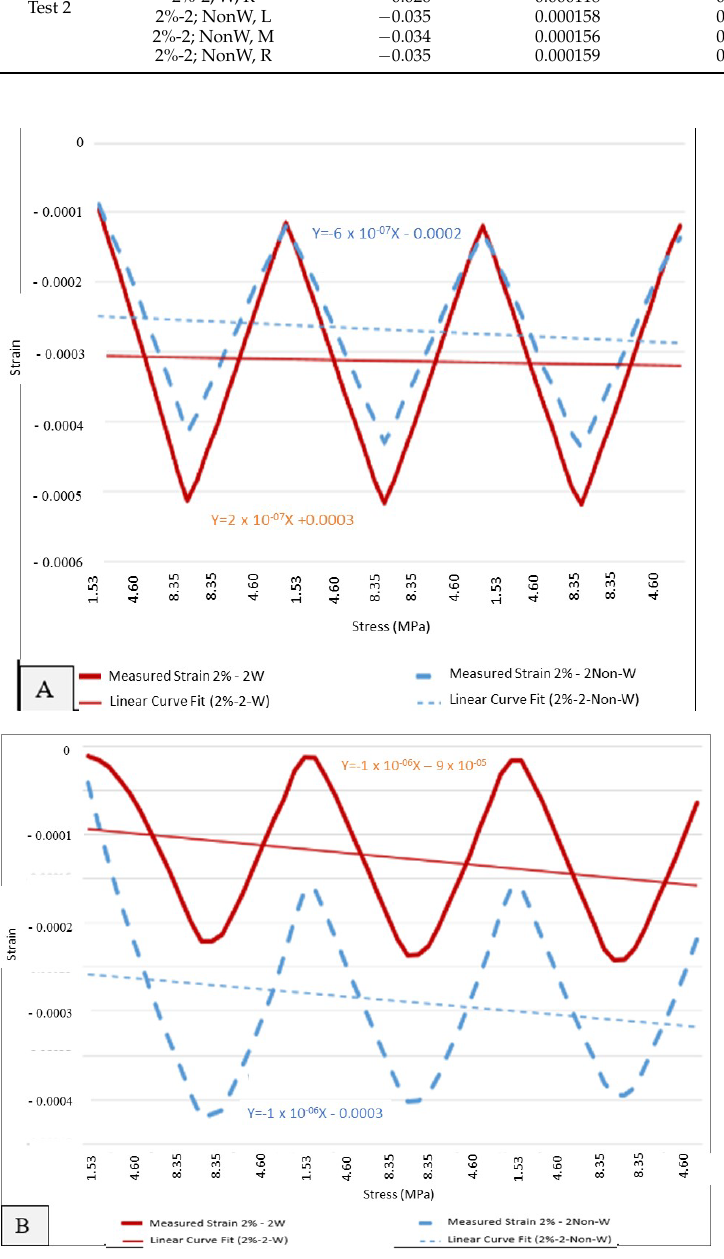
Figure 13. Strain Differences between Strain Gauge Measurements of the Wire and Non-Wire Faces for Test 1 ( A ) and Test 2 ( B ).